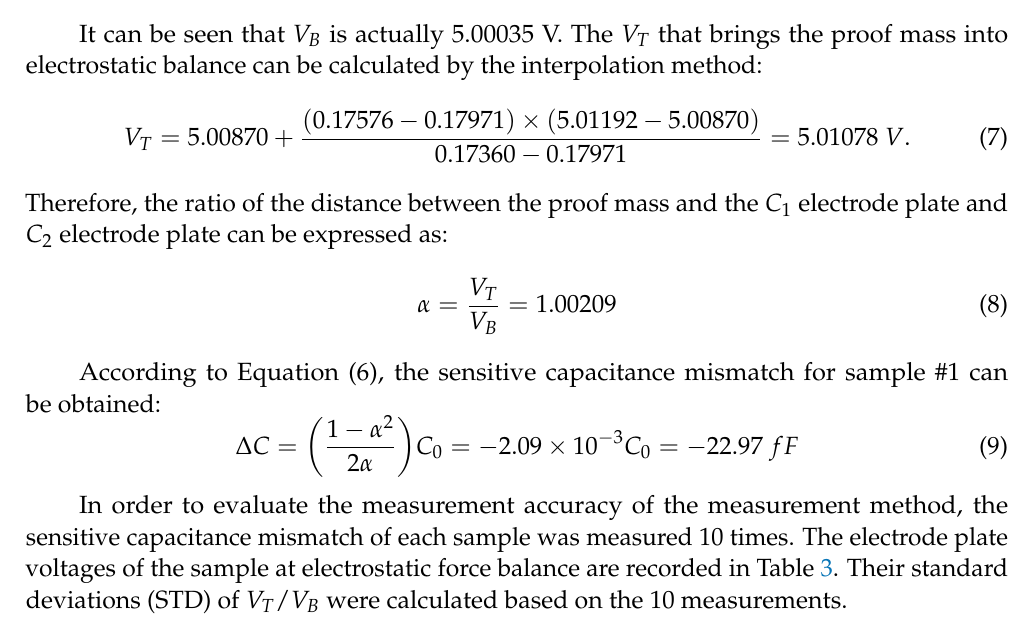
Table 3. The electrode plate voltage of the sample at electrostatic force balance (unit: V).